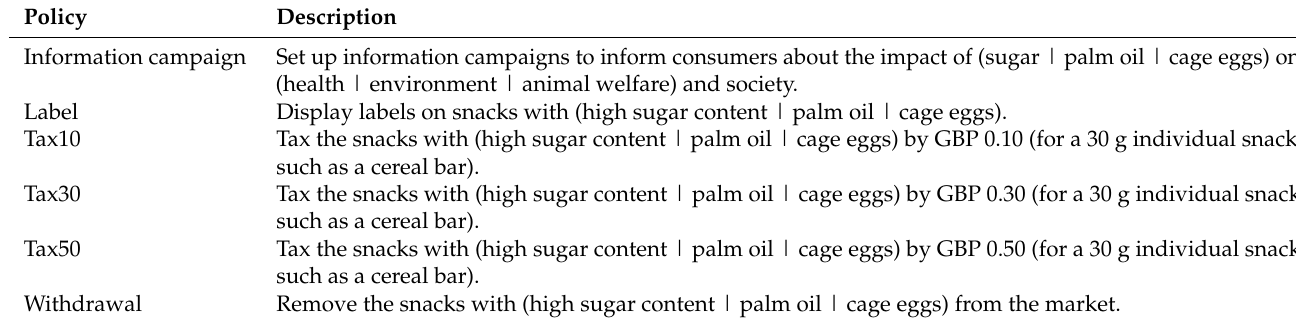
Table 2. Summary of